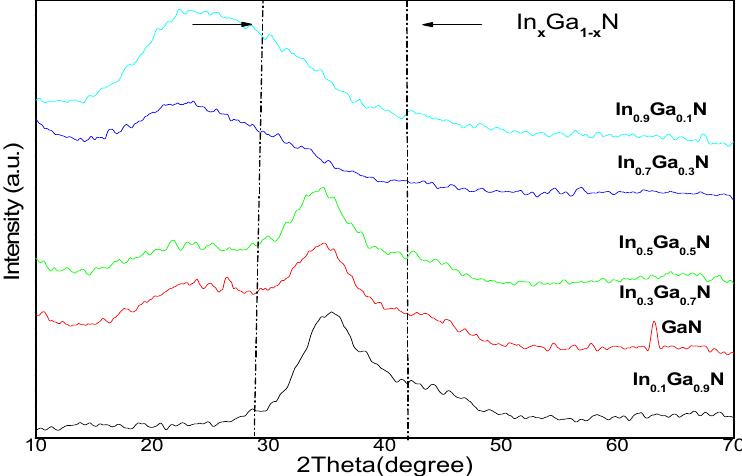
Figure 3. X-Ray di ff raction (XRD) patterns of the bulk In x Ga 1 − x N alloy at di ff erent In compositions (x = 0.1, 0.3, 0.5, 0.7, 0.9) prepared at 950 ◦ C for 2 Figure 3. X-Ray diffraction (XRD) patterns of the bulk In x Ga 1-x N alloy at different In compositions (x = 0.1, 0.3, 0.5, 0.7, 0.9) prepared at 950 °C for 2 h.